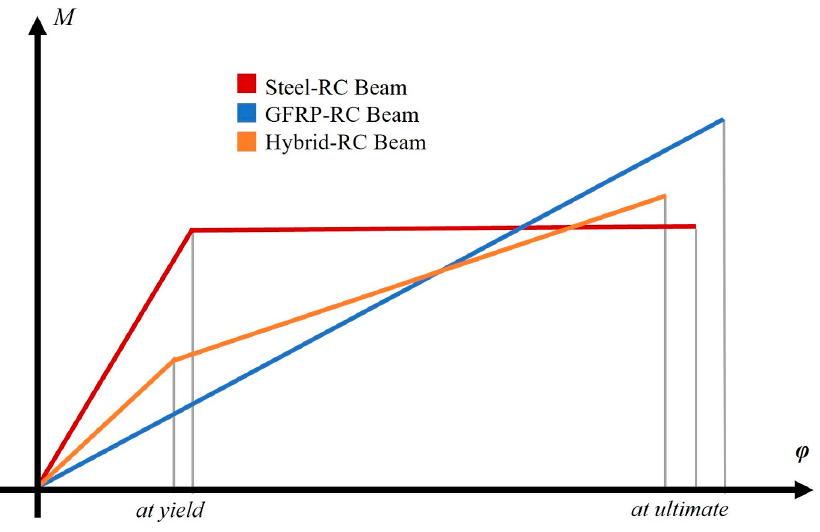
Figure 6. Moment–curvature for beams with different reinforcement systems [101]. Reproduced with permission from ASCE 2023.